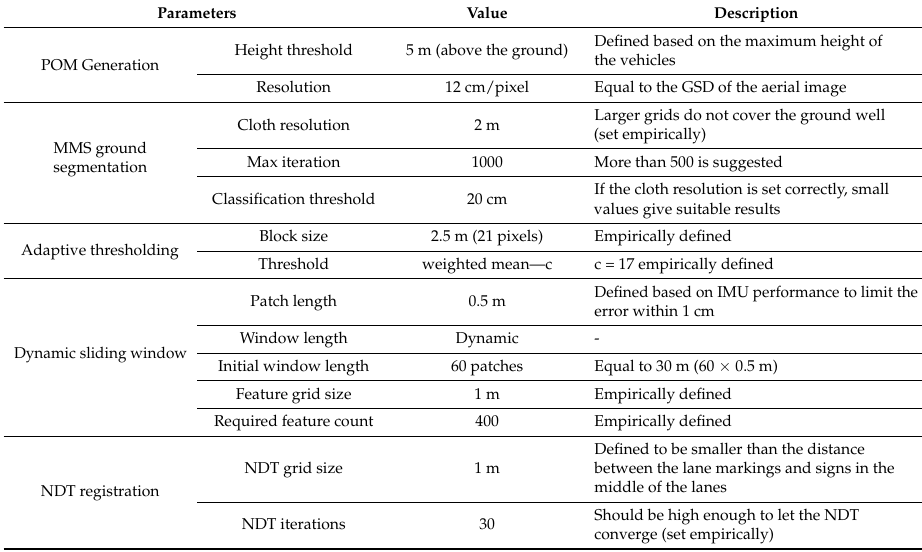
Table 2. Summary of the parameters applied in our